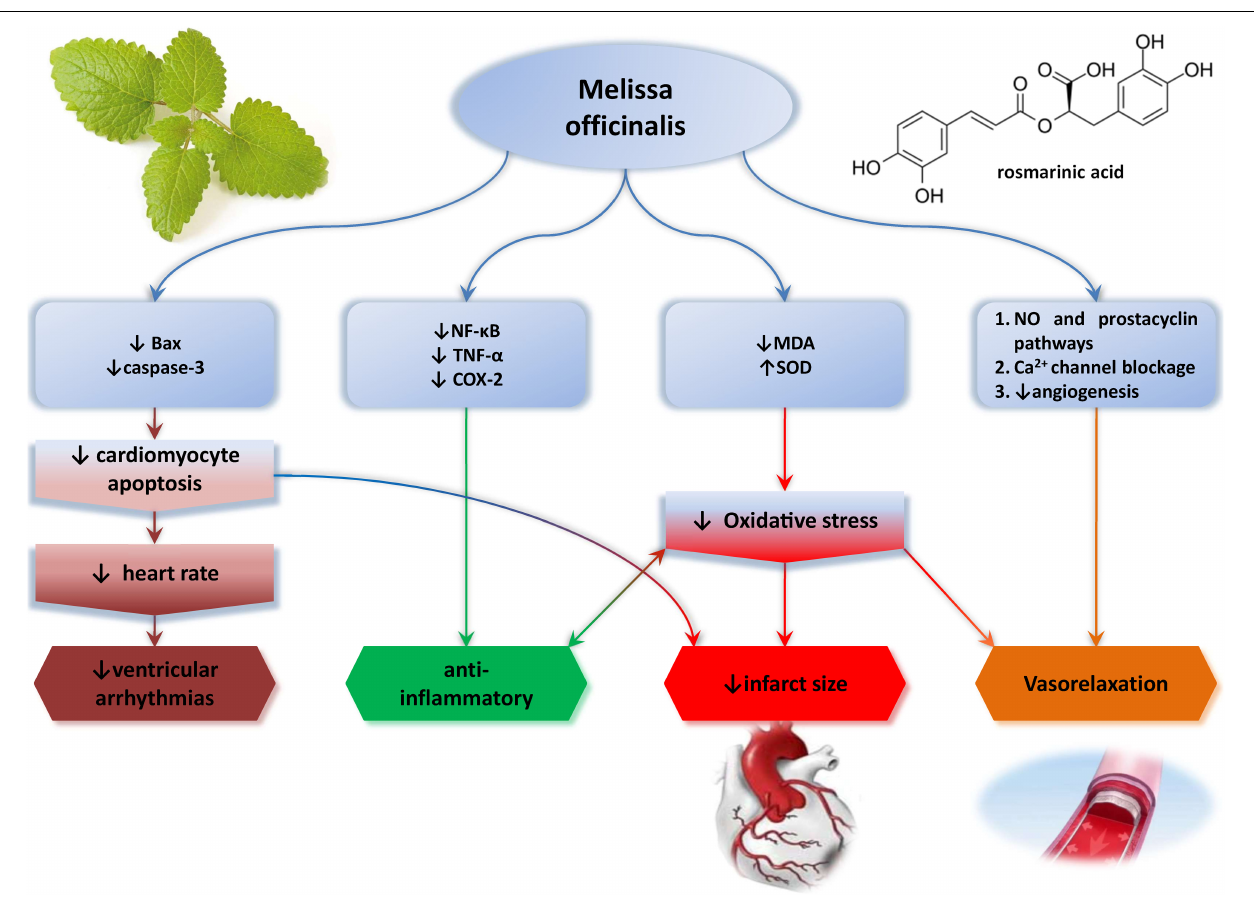
FIGURE 1 | Cardioprotection induced by Melissa officinalis